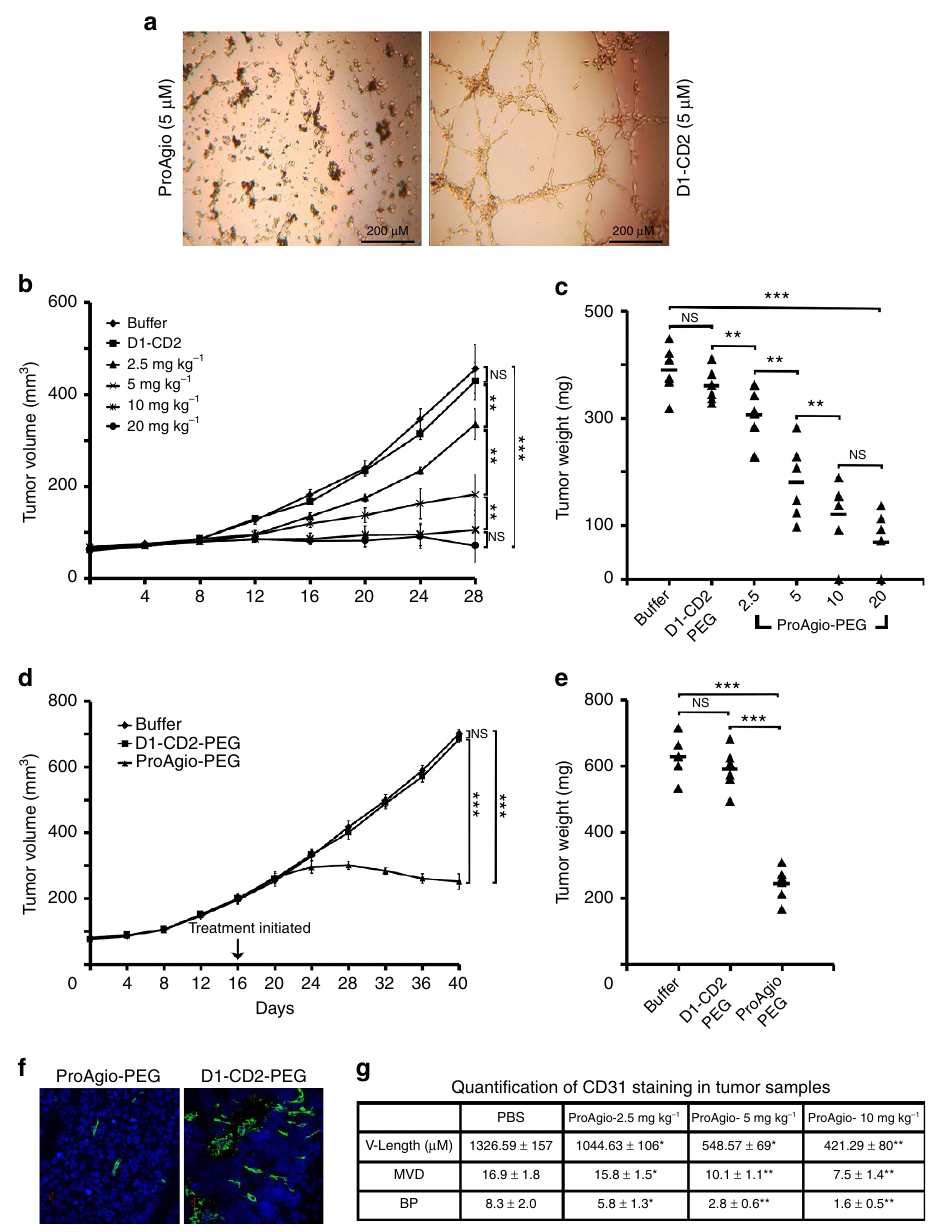
(Fig. 5f). Quantitative analyses of the CD31 staining indicated that there were marked reductions in vessel density, branch points and vessel lengths (Fig. 5g). To further assess the effectiveness, we carried out experiments to compare side-by-side the effect of ProAgio-PEG versus Avastin and ProAgio-PEG versus Endostar using the PC-3 xenografts. ProAgio-PEG was significantly more effective in the inhibition of tumour growth compared with those of the Avastin and Endostar